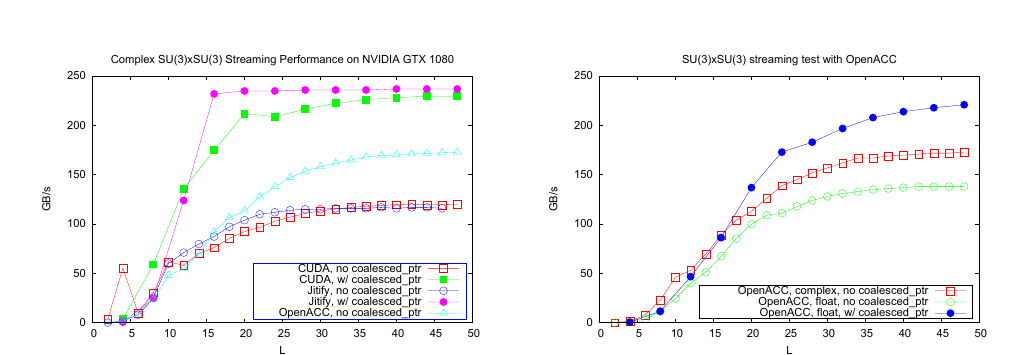
SU(3) streaming bandwidth ×